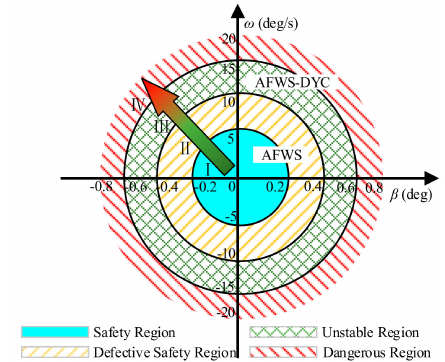
Figure 3. Working region of AFWS and